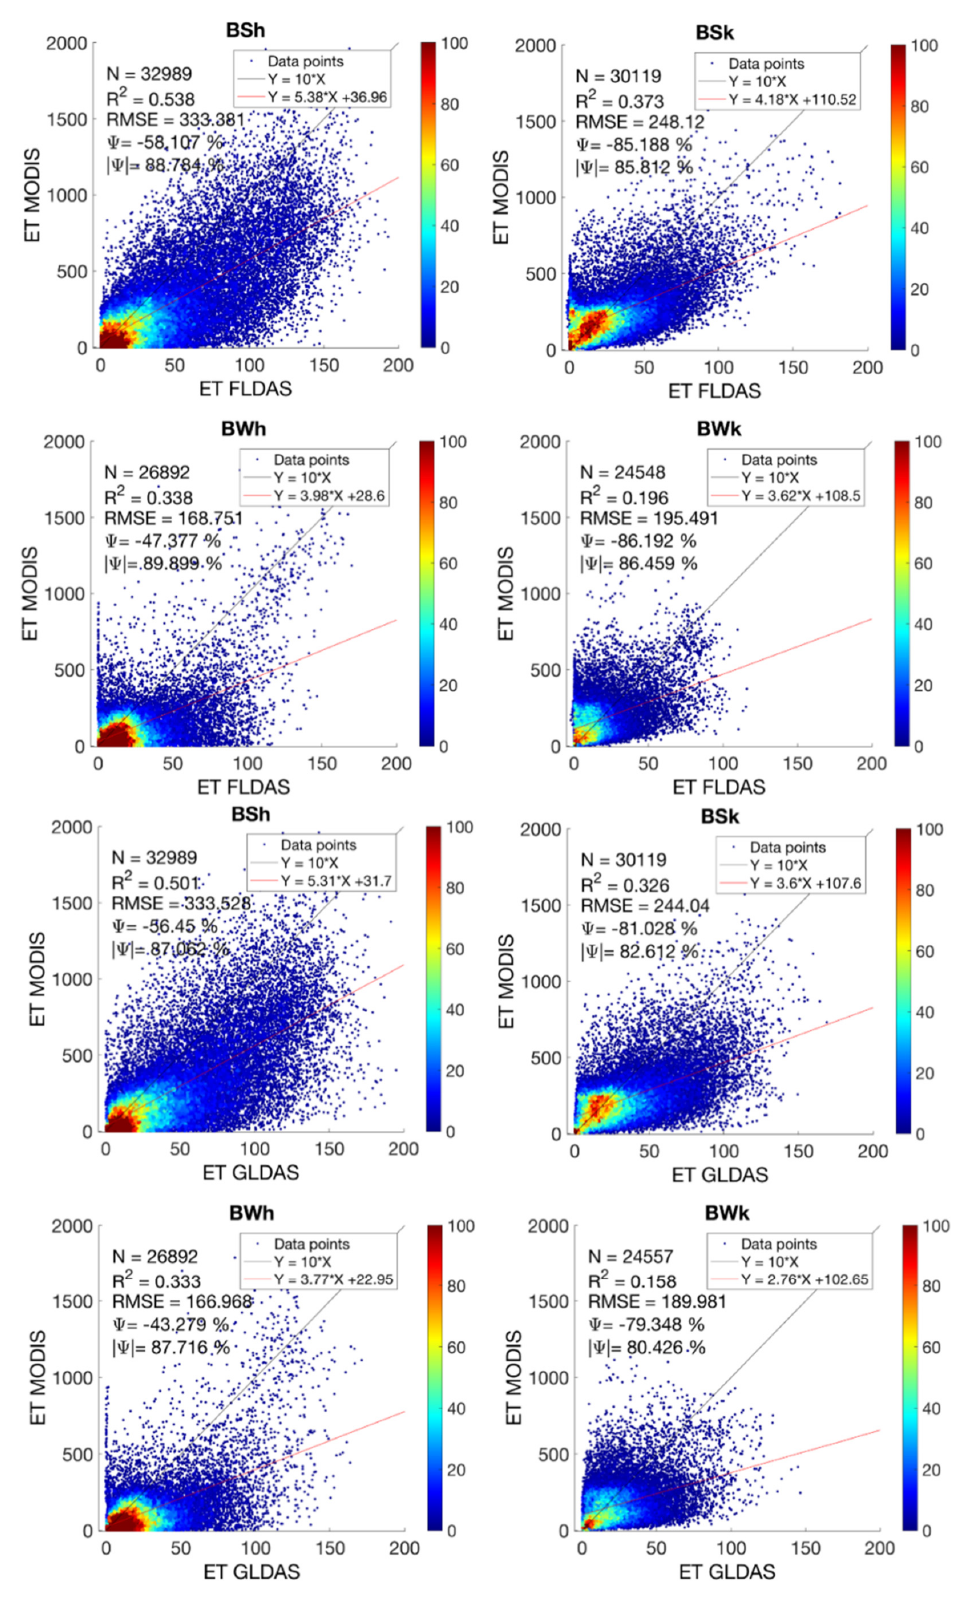
Figure 11. Comparisons of MODIS ET versus ET values obtained from FLDAS and GLDAS for all types of arid regions. The solid black and red lines represent the y = 10*x line and regression line, respectively.